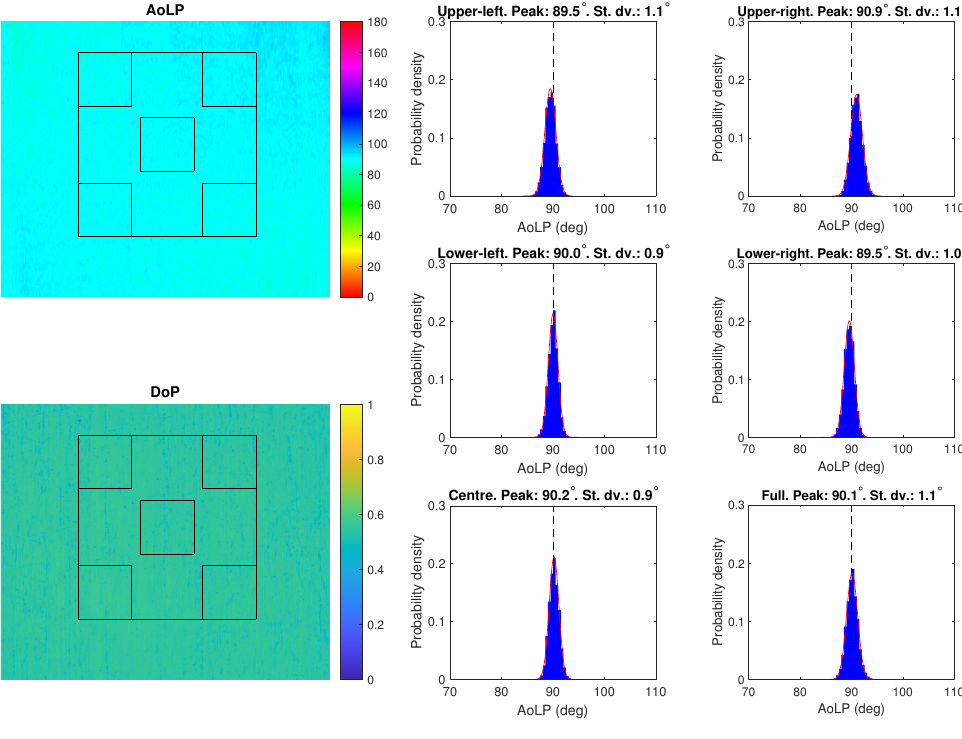
Figure 11. Results for a dry UD sample taken in similar conditions to the case of Figure 9.